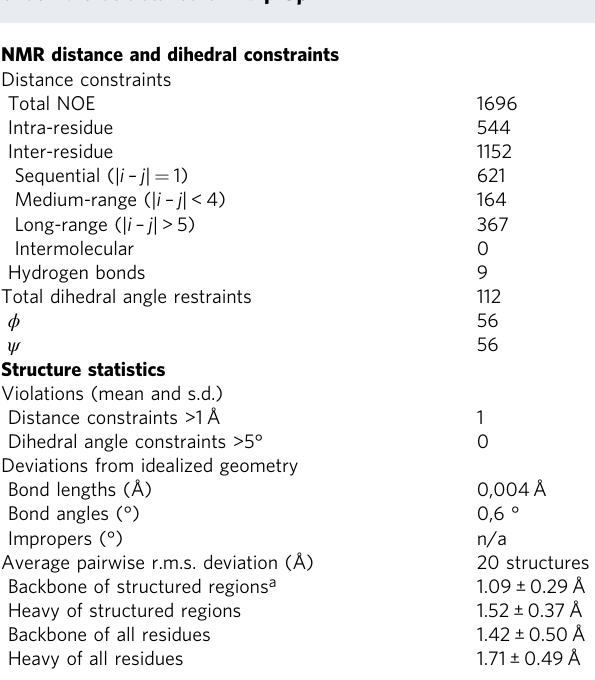
Table 1 NMR and re fi nement statistics for the fi nal 20 ensemble structures of Pvfp-5 β